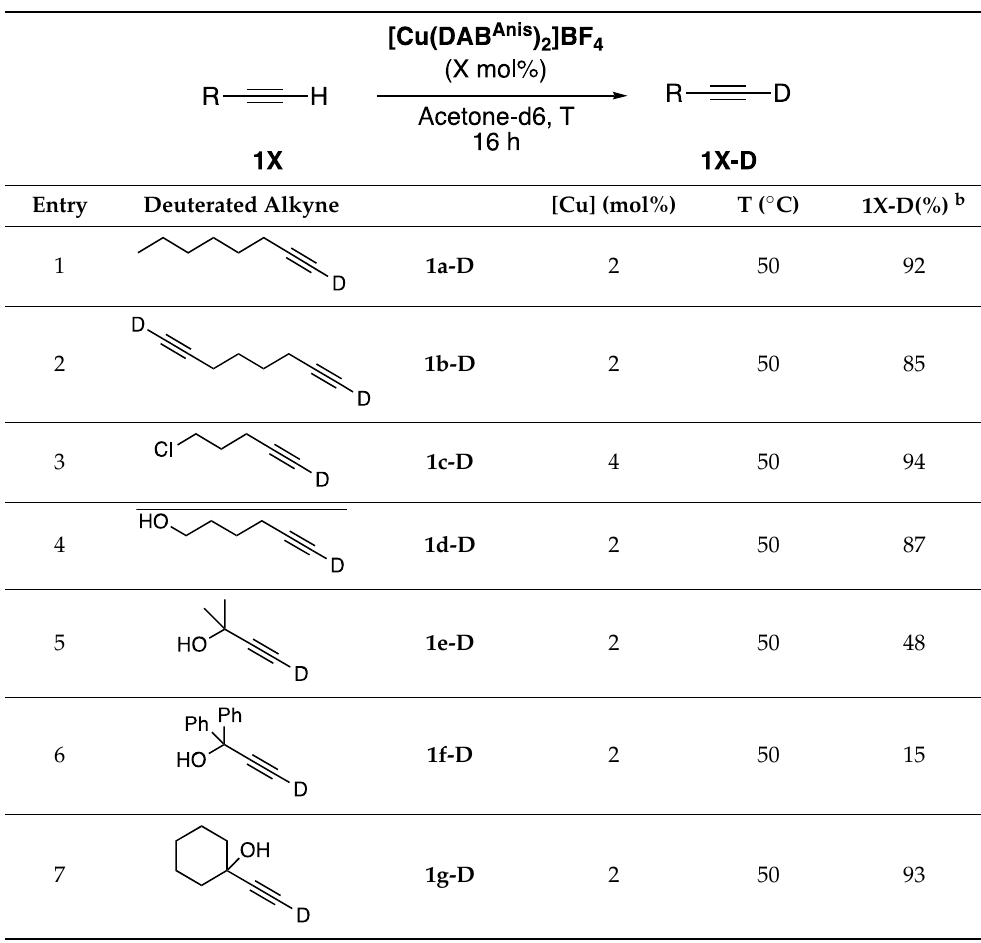
Table 3. Scope of the reaction a .